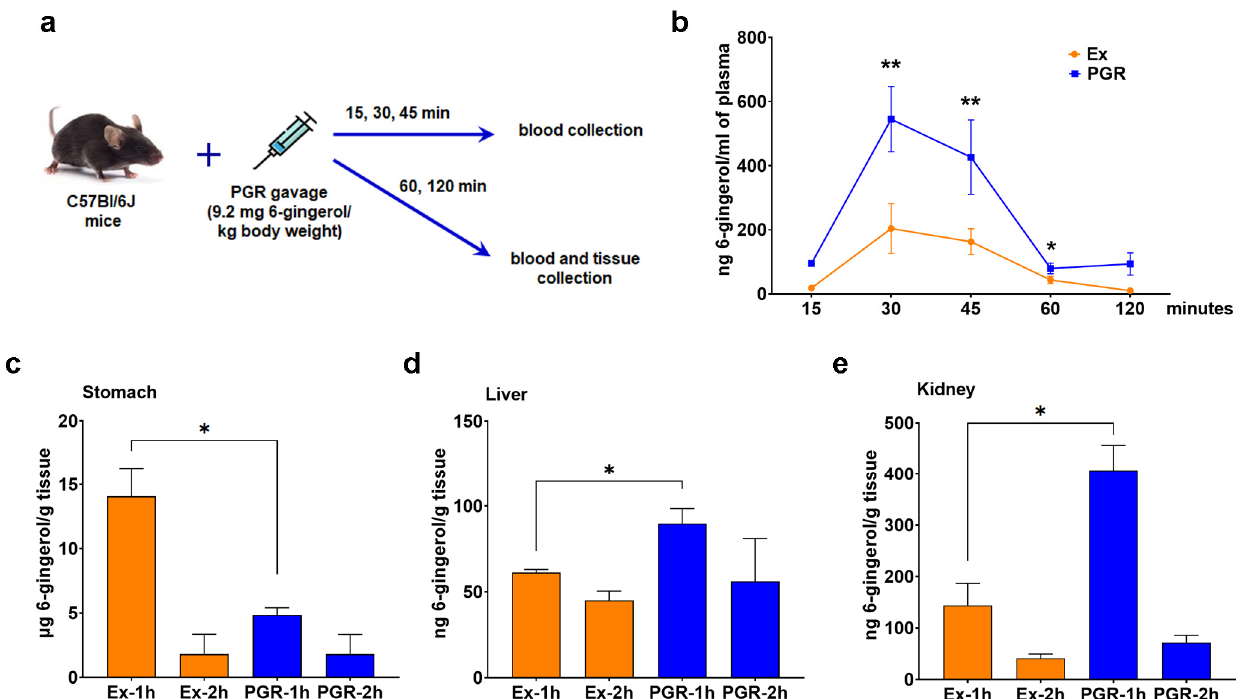
Figure 6. Experimental design ( a ) for the assessment of the bioavailability of free 6-gingerol levels in the plasma ( b ), stomach ( c ), liver ( d ) and kidney ( e ) of C57Bl/6J mice who received PHYTOGINROSA (PGR) compared to those who received extracts (Ex) at 15, 30, 45, 60 and 120 min post-administration. The results are presented as means ± SD for ( b ) and means ± SEM for ( c – e ); * p < 0.05 and ** p < 0.01 for PGR versus Ex.